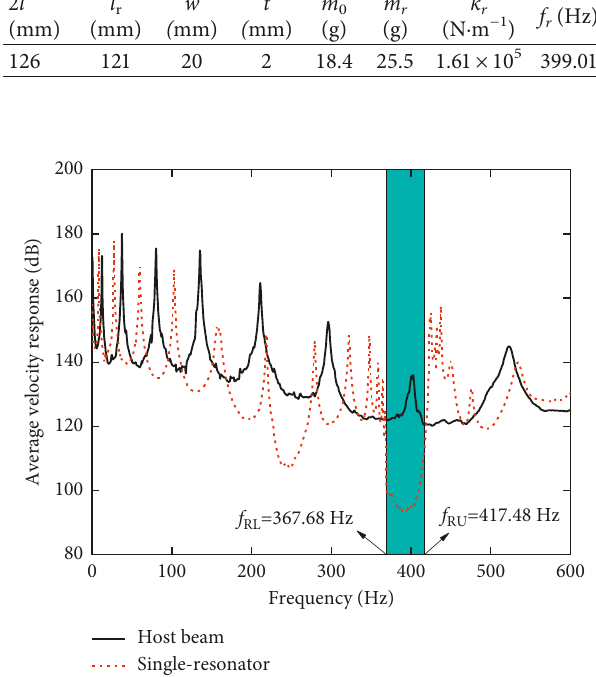
Figure 16: Average velocity responses of the simply supported beam without resonator and the locally resonant